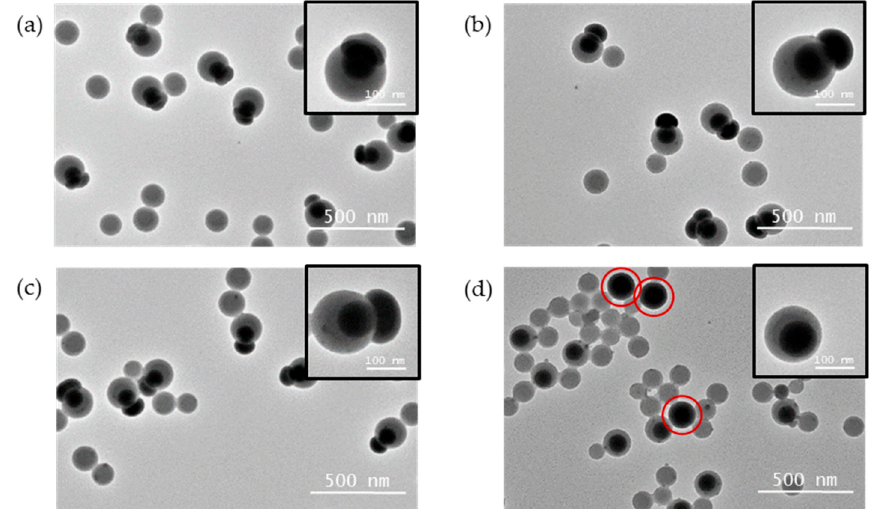
Figure 2. TEM images of silica/PS nanoparticles obtained for different nominal grafting surface densities d MPS and after silica regrowth: ( a ) 0.6 funct./nm 2 ; ( b ) 0.7 funct./nm 2 ; ( c ) 1 funct./nm 2 ; ( d ) 2 funct./nm 2 . The red circles show free silica particles obtained after the silica regrowth. The free PS particles observed in the images result from the polymerization step, because they were not removed by centrifugation for this series of experiments.